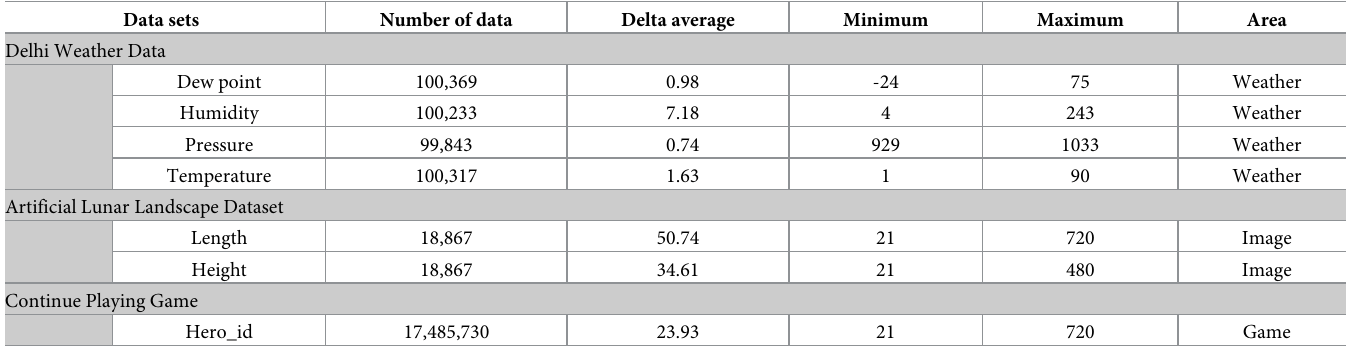
Table 6. Description of three real-world data